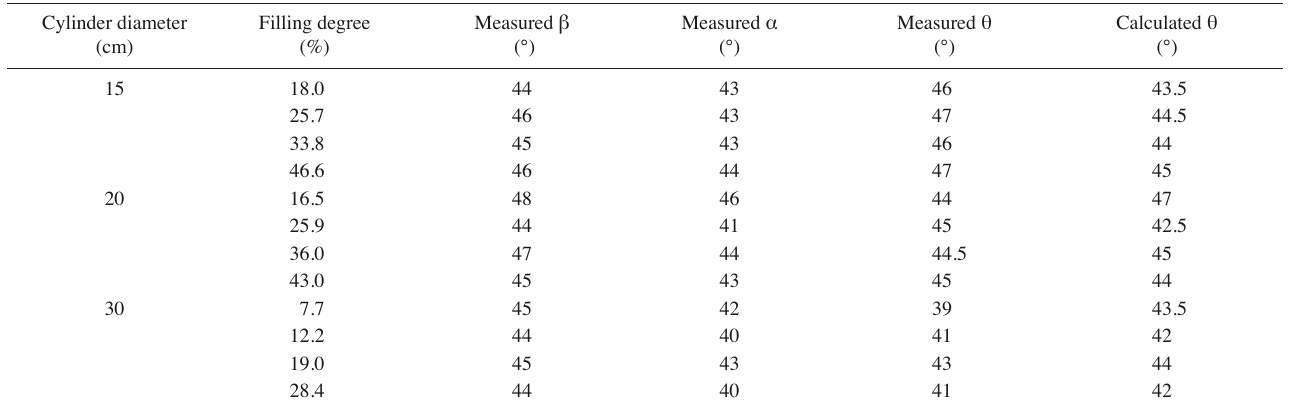
Tab. 4: Dynamic angle of repose in rolling mode for rice